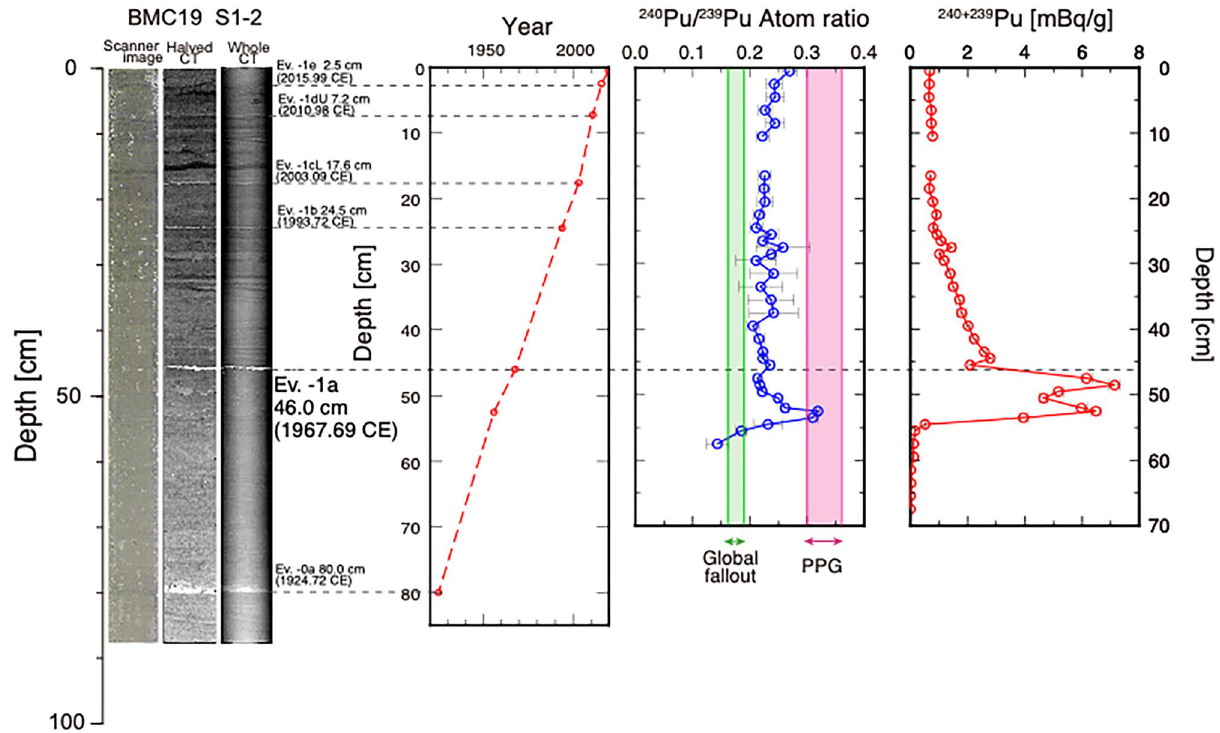
Figure 2. CT scan image of the Beppu Bay sediments and Pu measurements using Accelerator Mass Spectrometer (AMS). Horizons of geological event layers (e.g., Ev-1e, Ev-1dU etc.) can be recognized in images of cores and are traceable amongst cores taken from the basin 24 . They are formed by turbidite created from Tsunamis and other events. Ev.-1a at 46.0 cm bsf is recorded in historical documents with an age consistent with the Pb-210 age model. Pu isotope ratios and total activities are measured using Accelerator Mass Spectrometry 63 .